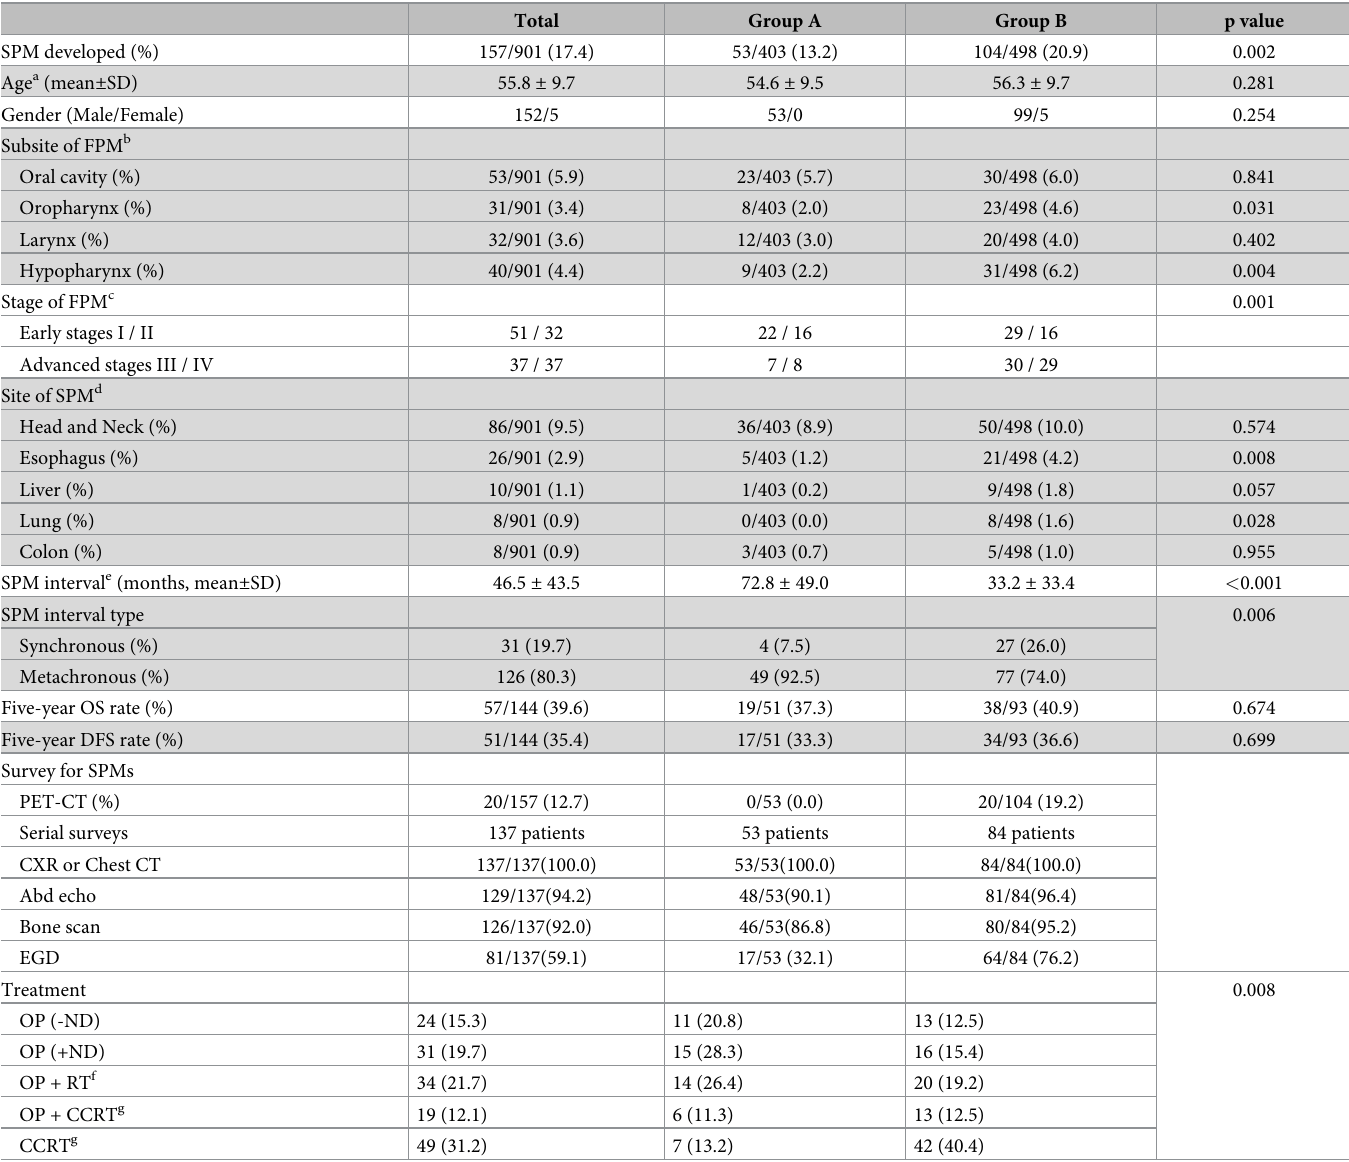
Table 1. Demographic and clinical characteristics in HNSCC patients of Group A and Group